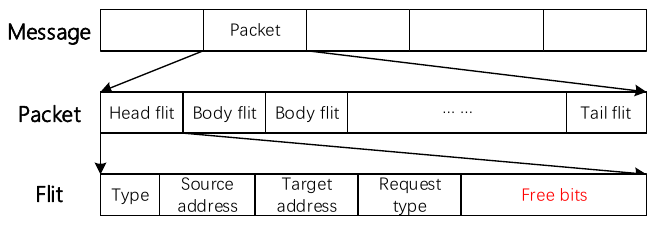
Figure 5. Packet